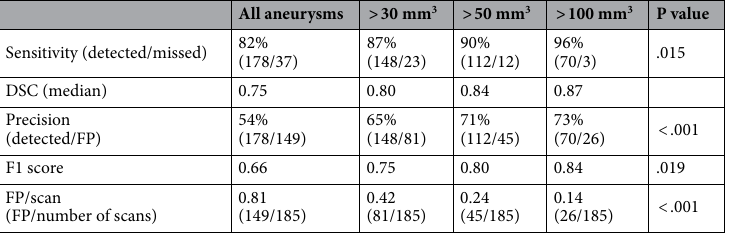
Table 4. Sensitivity, median dice similarity coefficient (DSC), precision, F1 score, and average false positive (FP)/scan of the DLM-Ens in the combined test cohort in relation to aneurysm